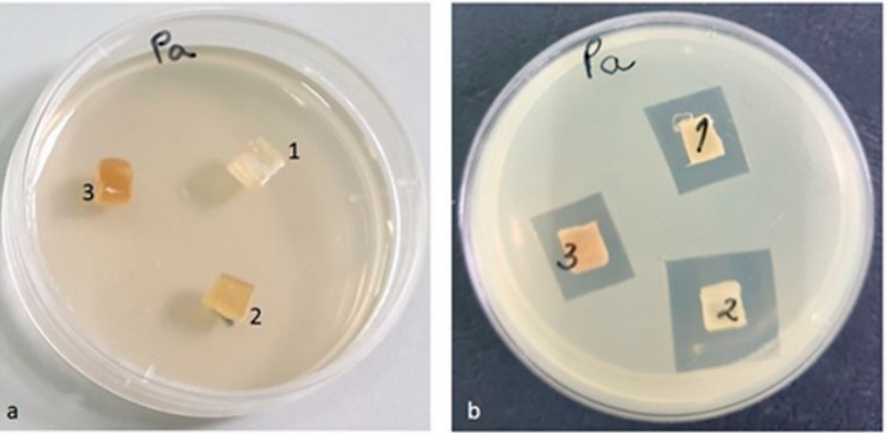
Figure 17. Pseudomonas aeruginosa ATCC 27853 ( a ) zero (initial) moment, ( b ) inhibition after 48 h of incubation.